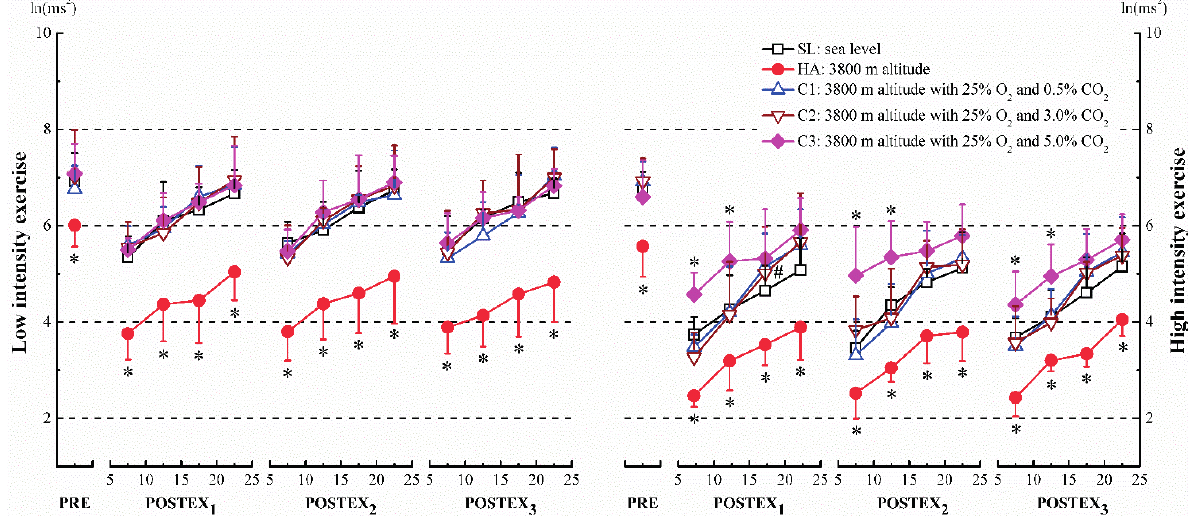
Figure 4. High frequency (HF) in pre-exercise (PRE) and post-exercise (POSTEX 1 , POSTEX 2 and POSTEX 3 ). * p < 0.05, compared with SL in the same segment and exercise intensity. # p = 0.049, C2 compared with SL in POSTEX 1 15–20 after high intensity exercise.